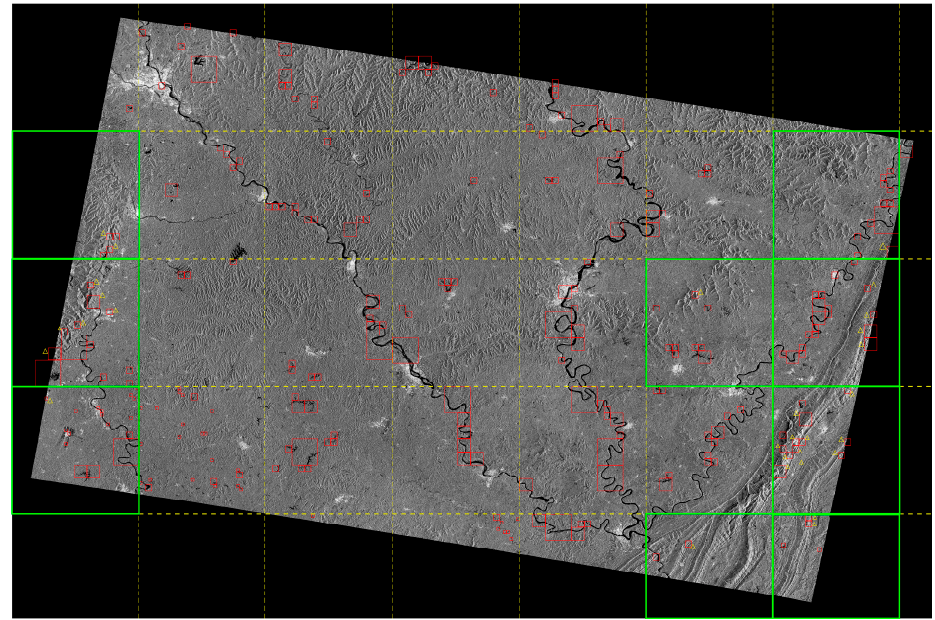
Figure 7. Sentinel-1 VV polarized data of the study area (15 July 2018) with the target bimodal regions (in red boxes) using Chini’s method, where the false alarms are notated by the yellow triangle beside them.